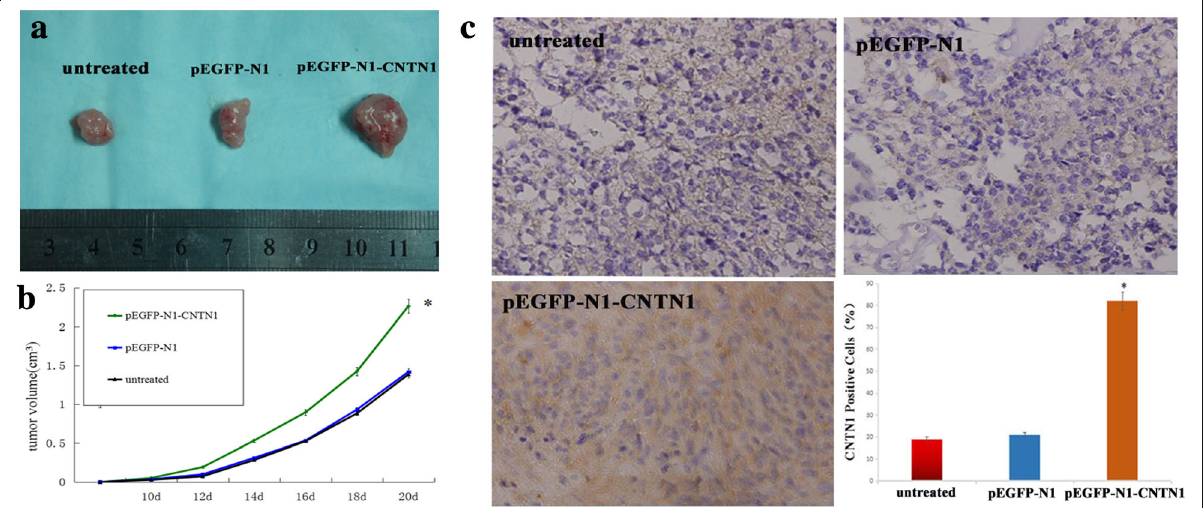
Fig. 5 CNTN1 overexpression promotes growth of Hs578T cells in mouse xenograft model. a Representative images of tumors collected from mice at day 21. b Overexpression of CNTN1 promotes growth Hs578T tumors in vivo ( n = 6/group). Data are expressed as mean ± standard error. * P < 0.05; pEGFP-N1-CNTN1 vs. untreated or pEGFP-N1 cell groups. c Immunohistochemical staining of tumor specimens. Data are represented as mean ± S.D. (* p <